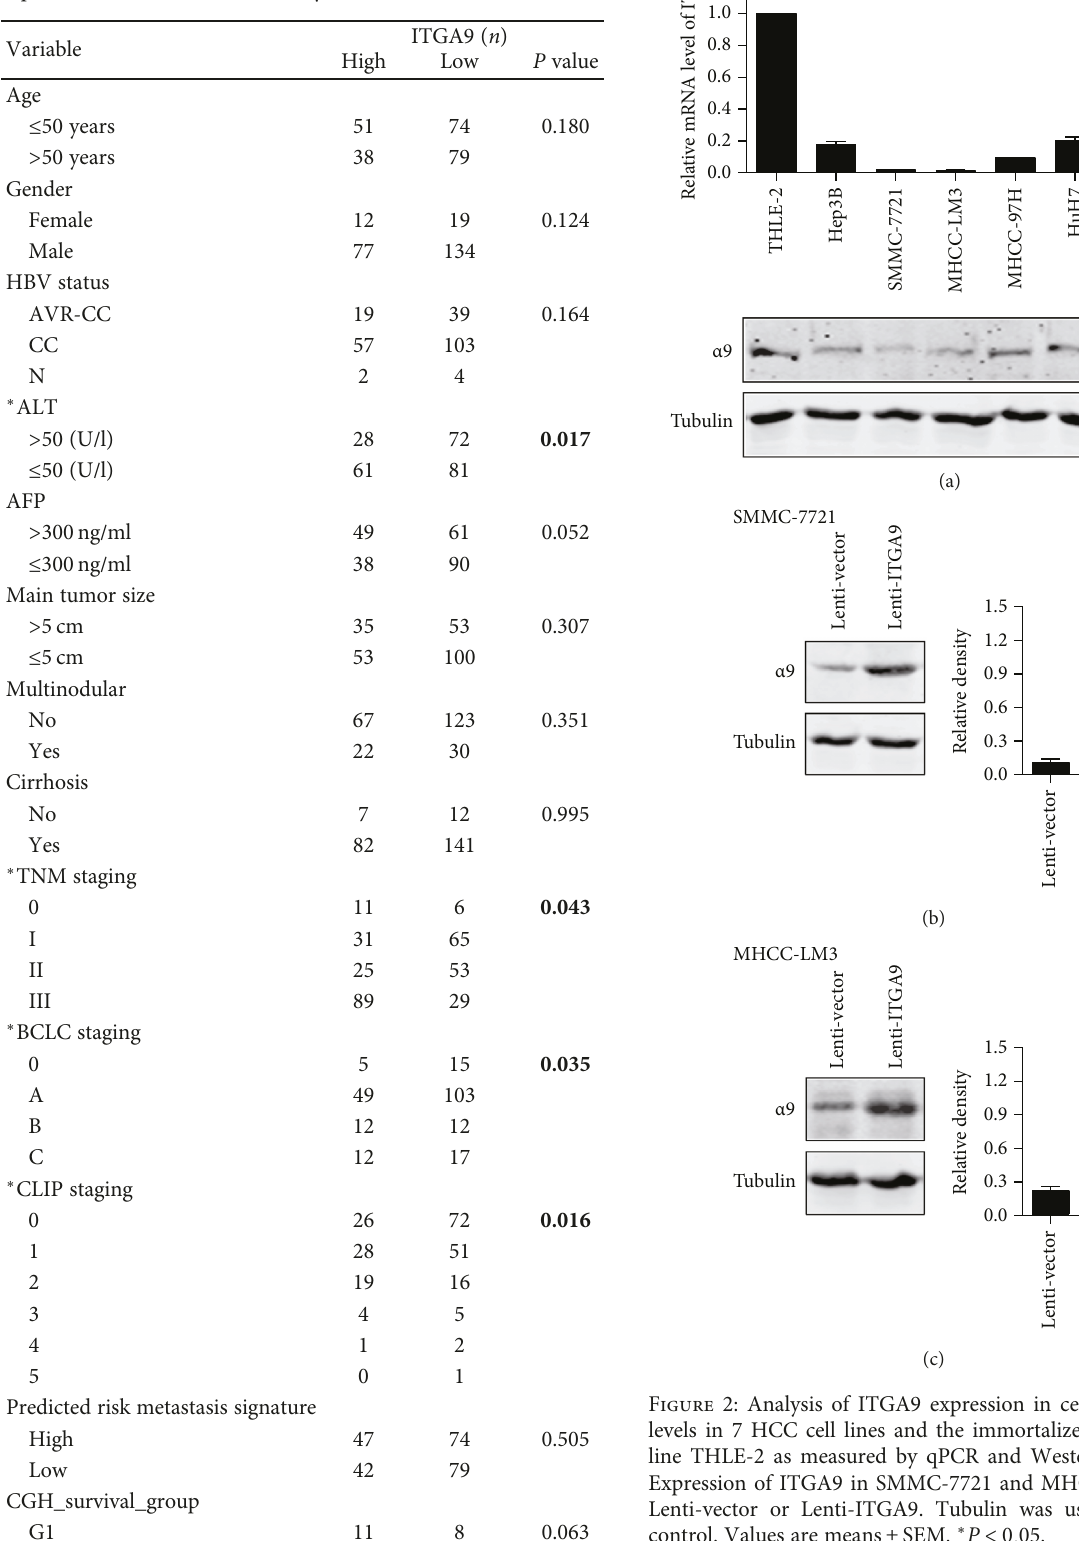
Table 2: Correlation of clinicopathological features with ITGA9 expression in GSE14520 microarray